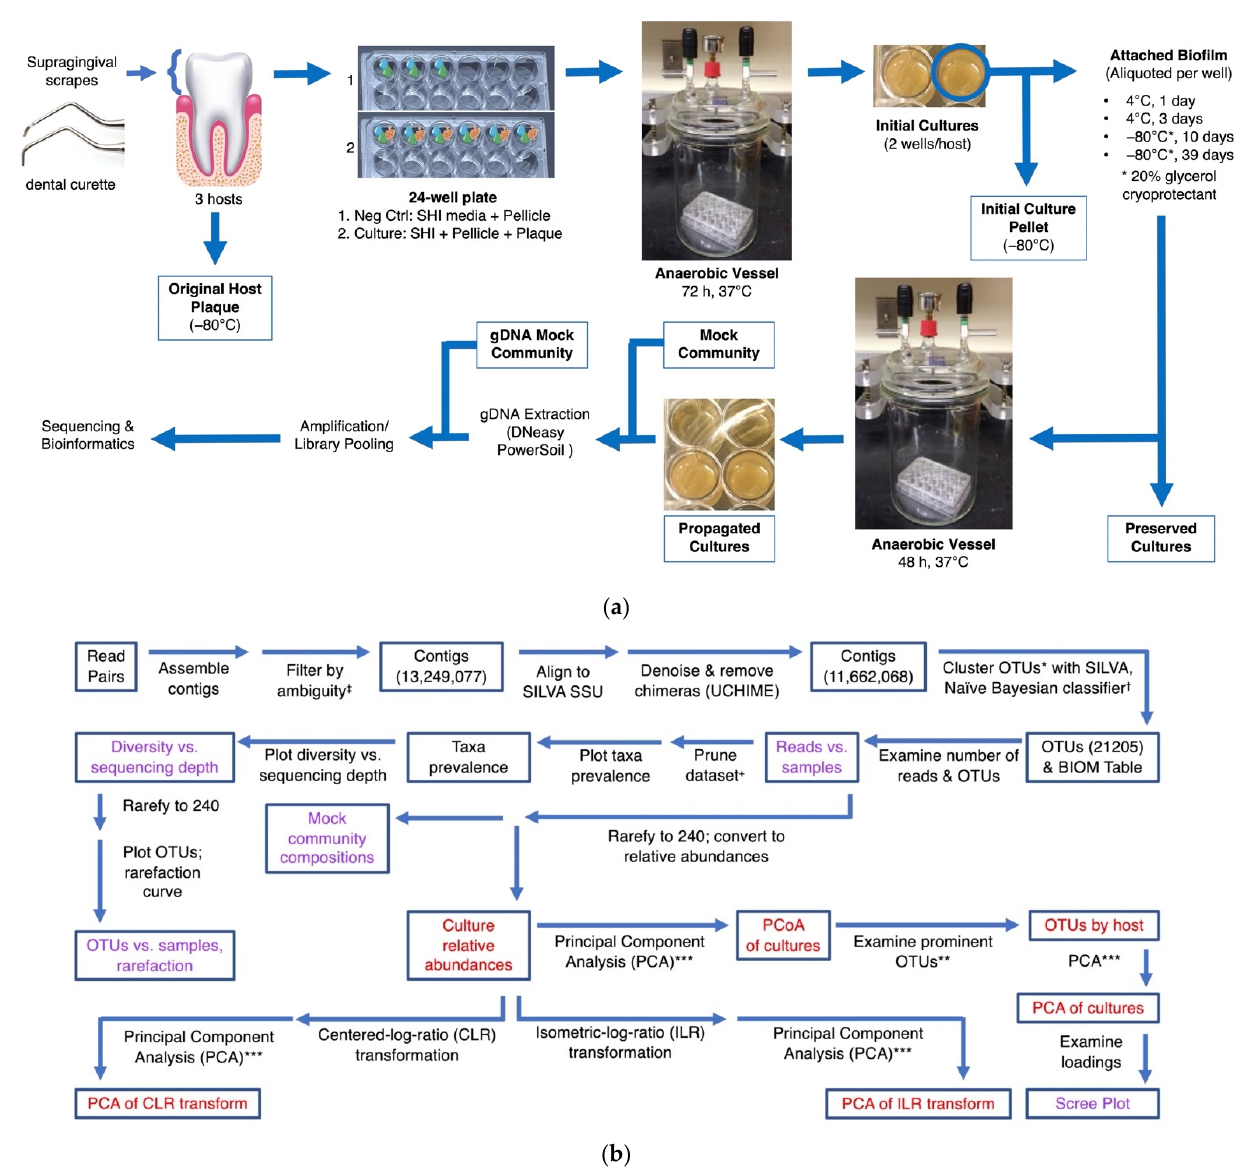
Figure 1. Experimental design and bioinformatic analysis. ( a ) Experimental scheme for preservation and propagation experiments; blue boxes around text indicate samples that were analyzed. Nega-